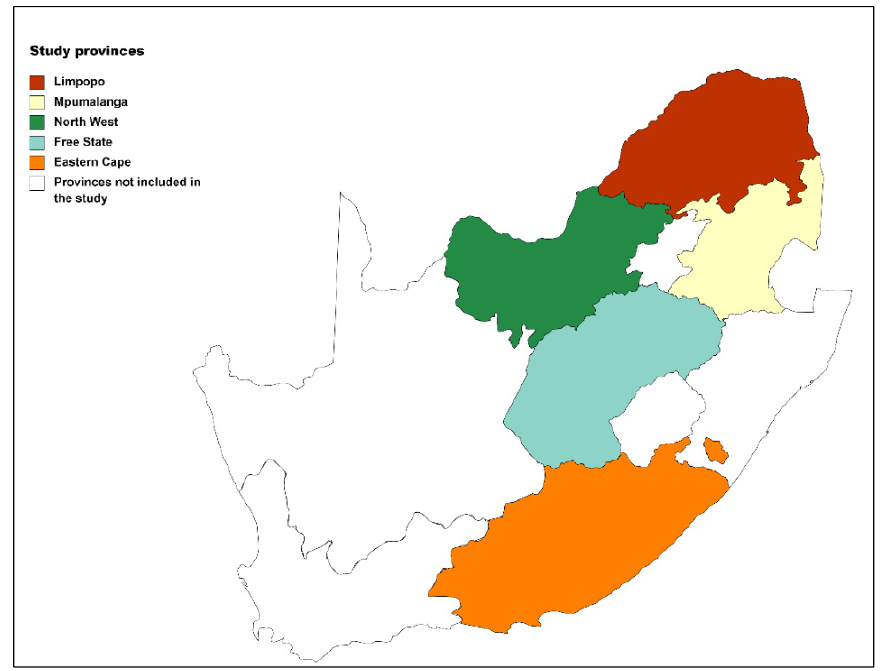
Figure 1. A map of SA showing the provinces where data were collected.